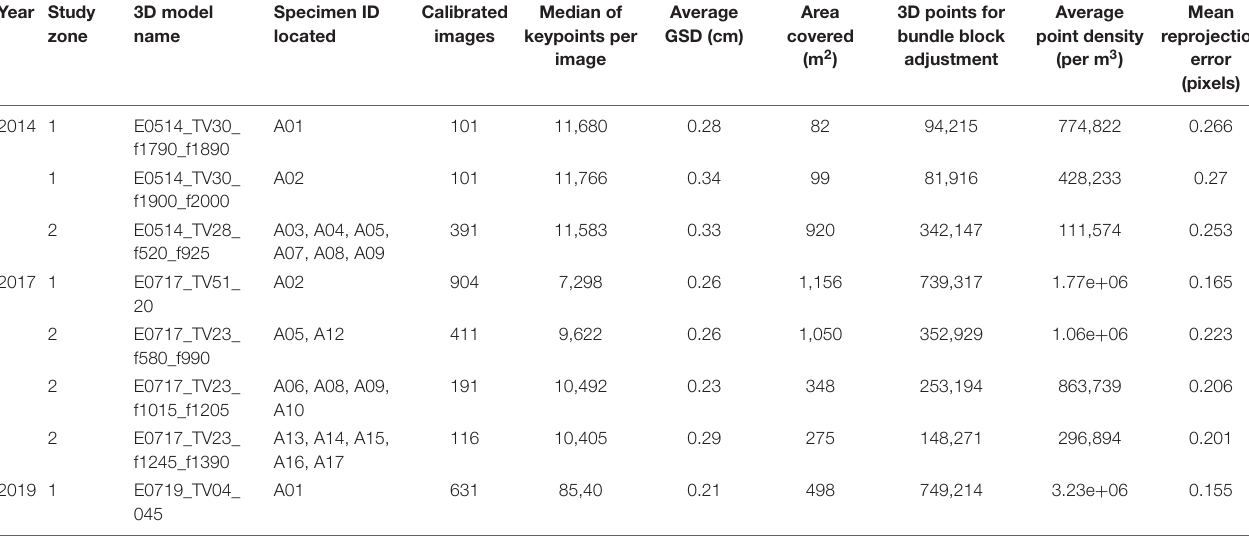
TABLE 1 | Summary of 3D models characteristics and specimens ID located in